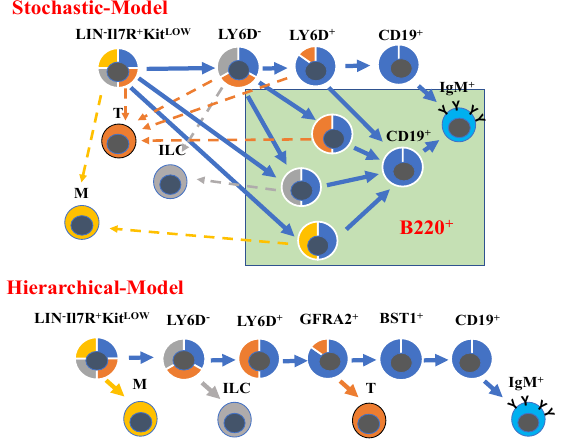
Figure 1. Developmental trajectories in B-cell development. Schematic drawing displaying two models for the developmental trajectories in B-cell development. Yellow indicates myeloid potential (M), gray indicates potential to generate innate lymphoid cells (ILC), orange indicates T lineage potential (T), and blue indicates B-cell potential. The arrows indicate potential developmental trajectories for the defined lineages. The green square indicates B220 + populations.